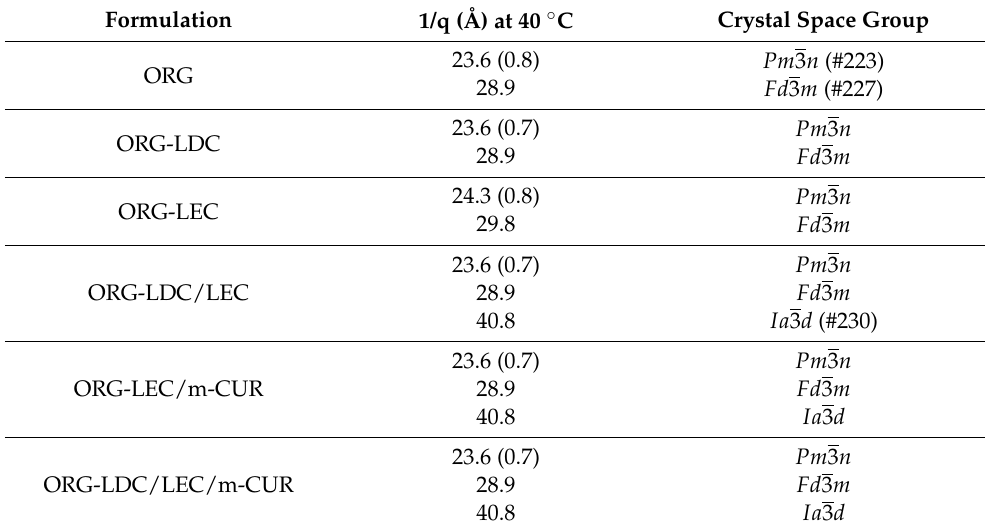
Table 4. 1/q values (Å) at 40 ◦ C, as well as the assigned crystal space groups to the different cubic phases found in the ORG samples from SANS